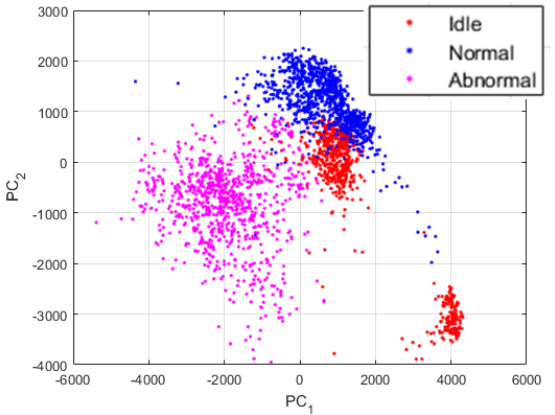
Figure 13. Projections of the data represented by their PSD-images. Also, 2993 data are shown here.